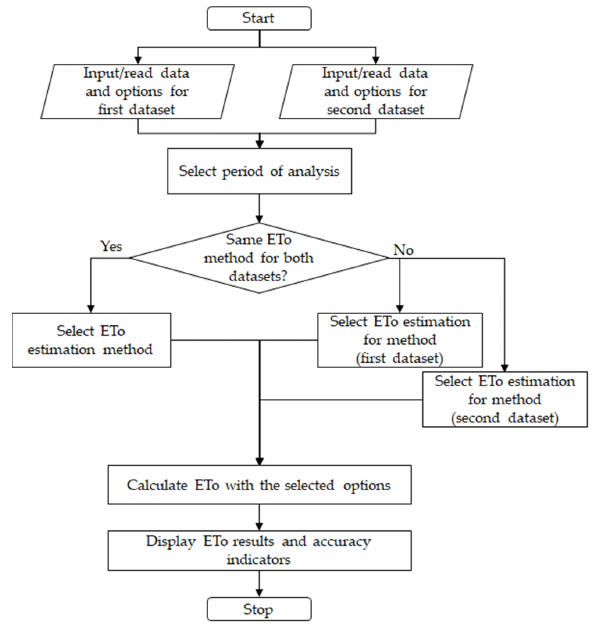
Figure 1. Simplified flow chart of ETo Tool application.